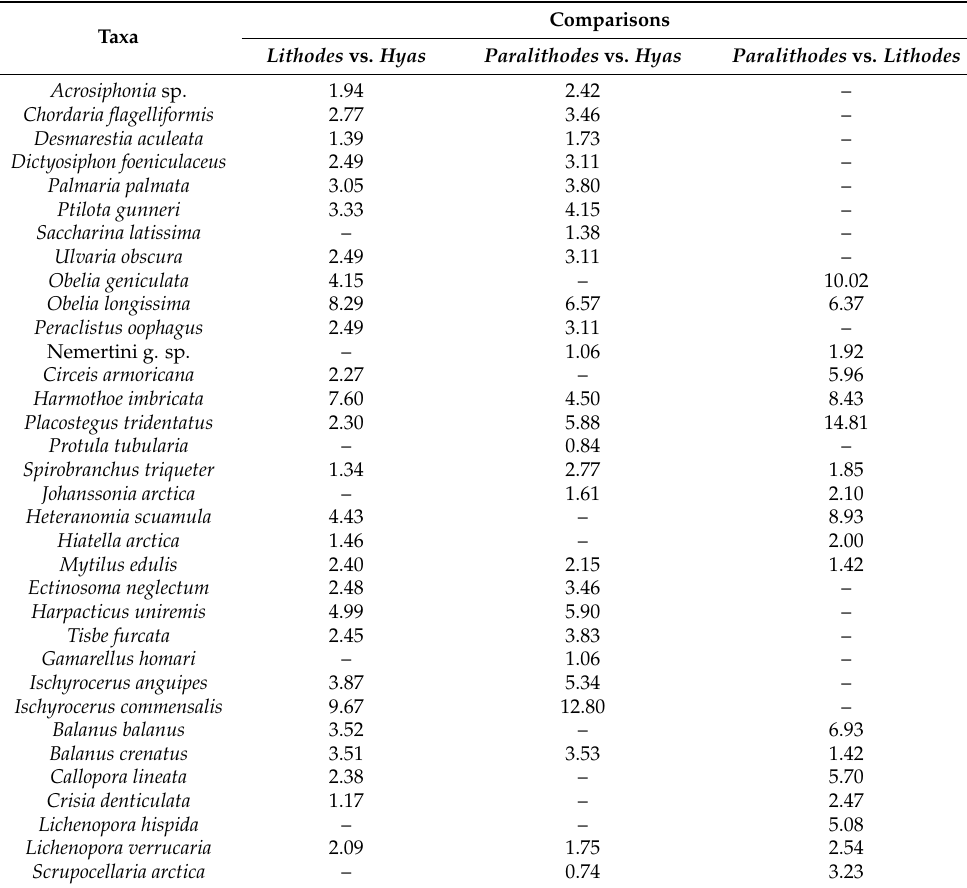
Table 2. Results of the SIMPER analysis on infestation indices: contributions of main taxa (%) to dissimilarities within different crab species in the coastal Barents Sea. Comparisons Taxa Lithodes vs. Hyas Paralithodes vs. Hyas Paralithodes vs. Lithodes Acrosiphonia